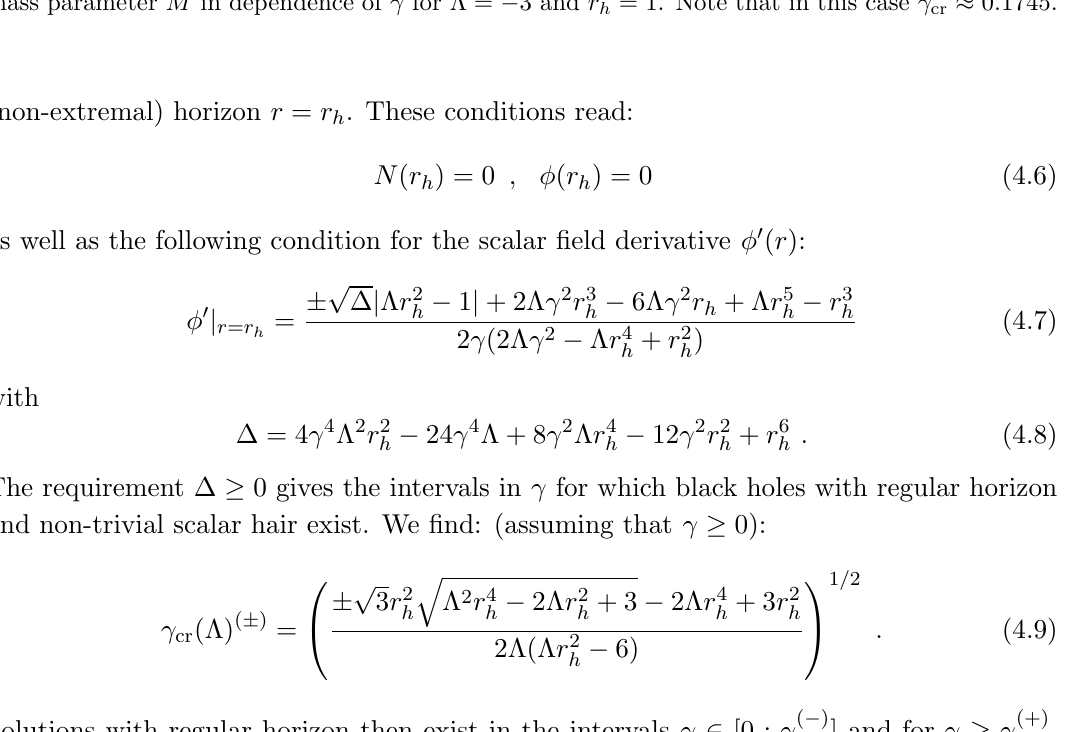
(see (4.7)) as well as the h